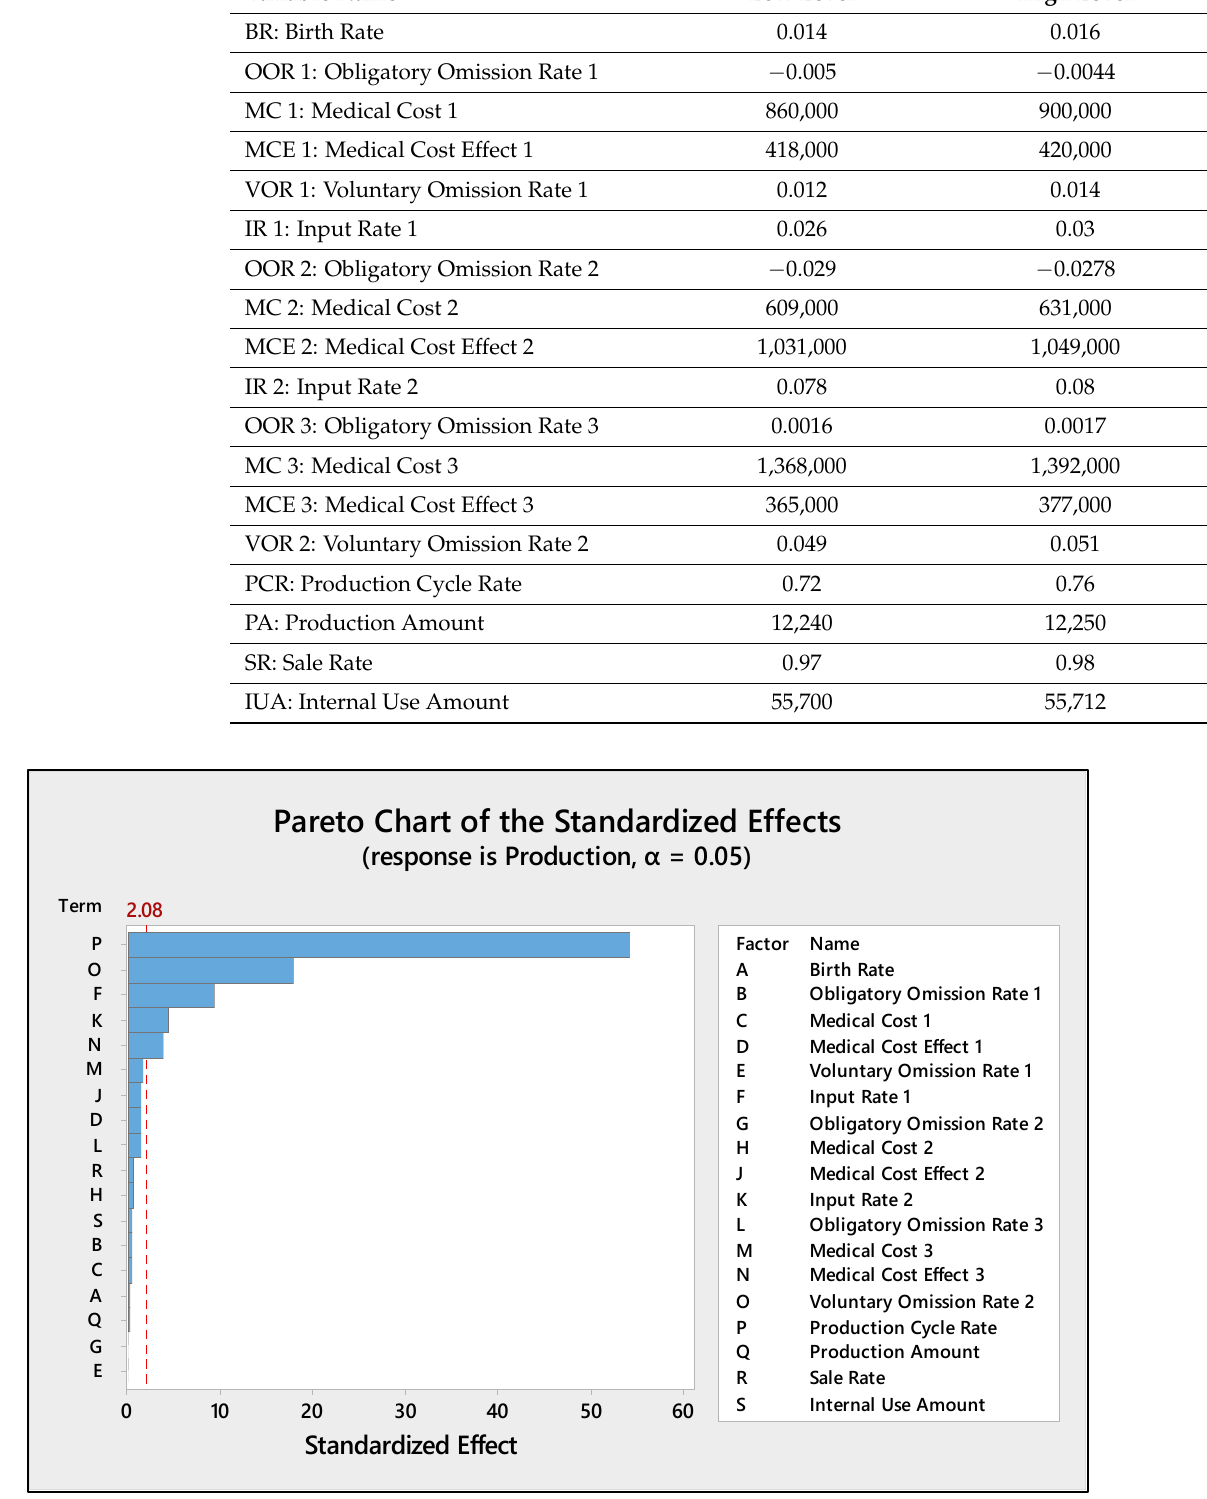
Figure 6. Pareto chart for the identification of important variables in production.